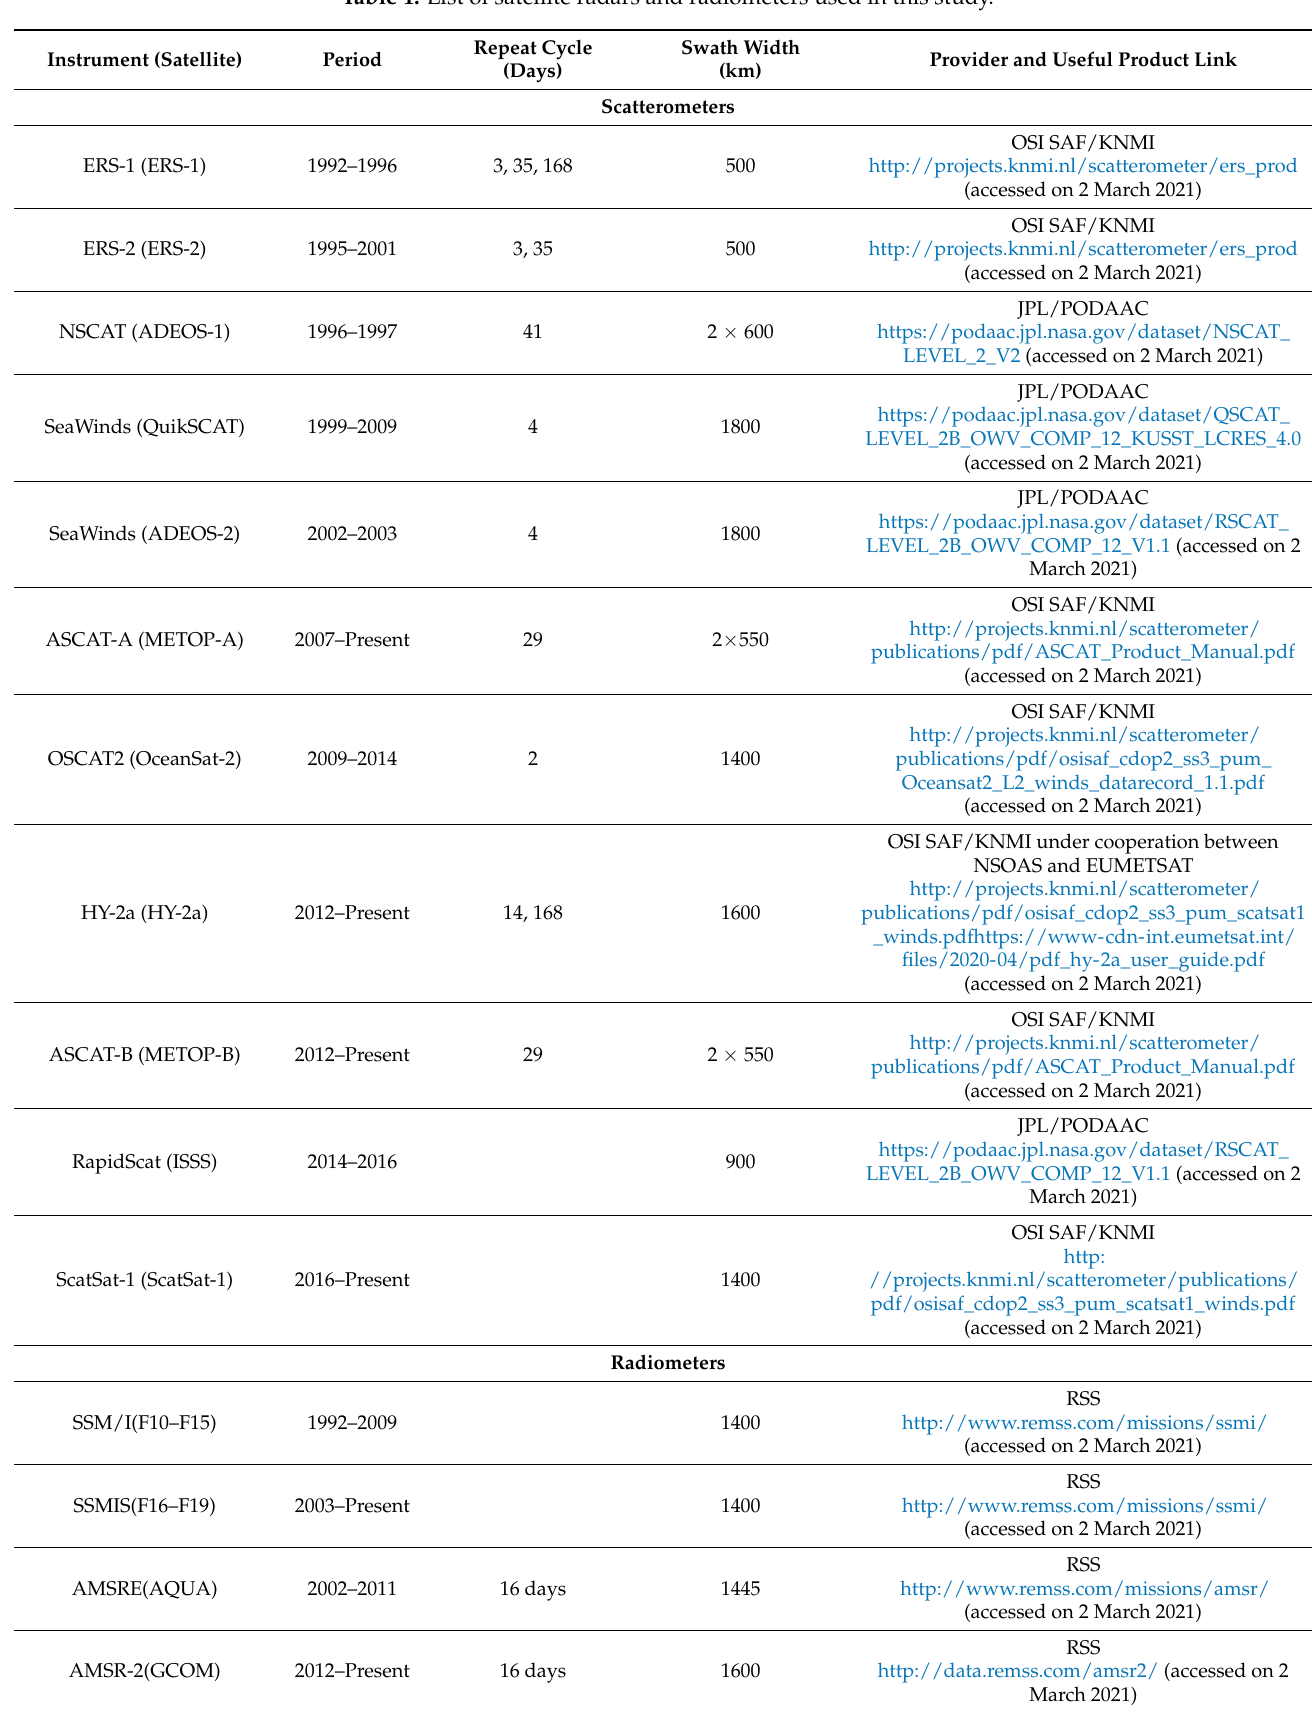
Table 1. List of satellite radars and radiometers used in this